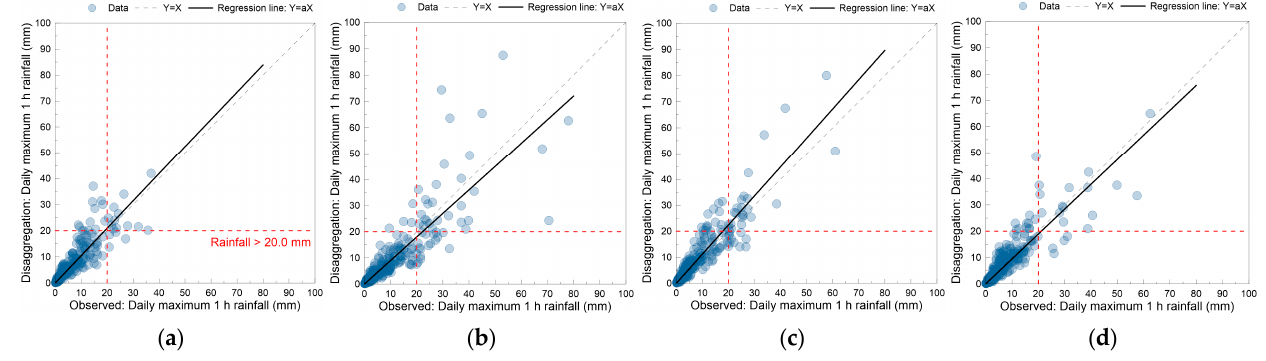
Figure 7. Scatter plots of daily maximum 1 h rainfalls from the observed data ( X -axis) and the disaggregation method ( Y -axis). ( a – d ) show Ulsan, Busan, Changwon, and Miryang in order. The red dotted line is a threshold of 20 mm rainfall. The solid black line is a regression line in Y = a·X formula.